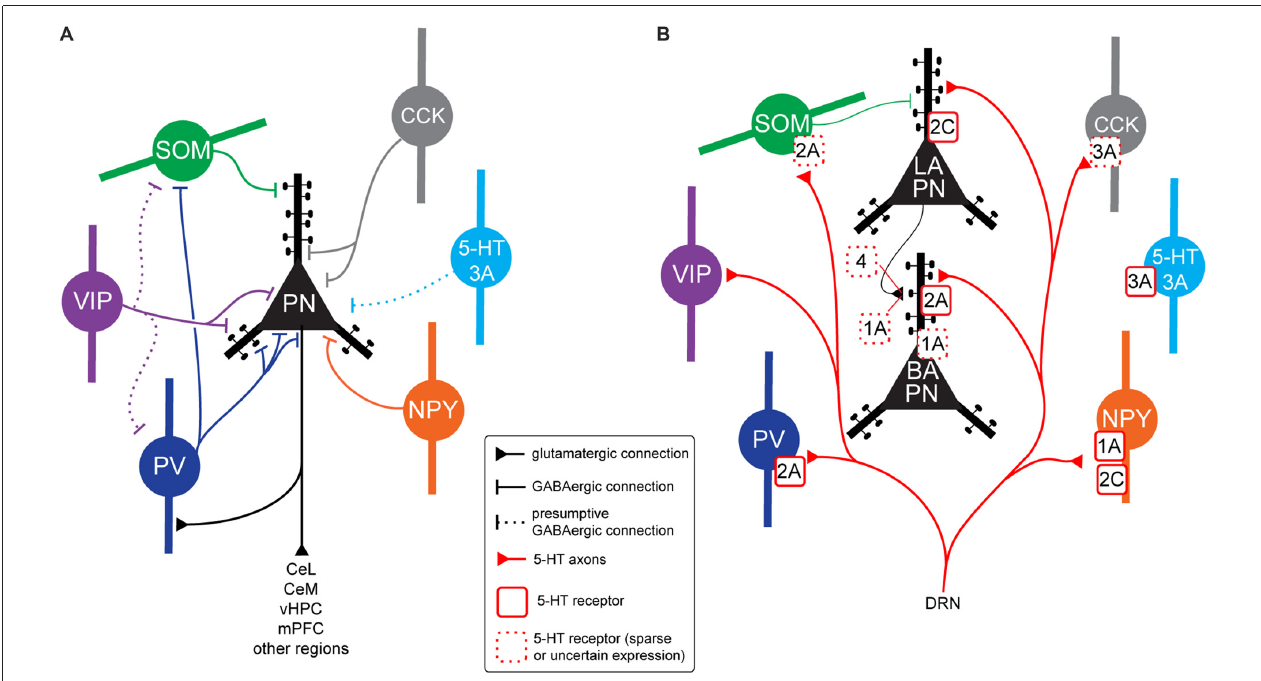
FIGURE 2 | BLA neurons connectivity, 5-HT innervation and 5-HT receptor expression. (A) Connectivity between BLA principal neurons (PNs) and interneuron (IN) populations in rodents. Parvalbumin (PV) INs target the perisomatic region of PNs (soma, proximal dendrites, axon initial segment), but also inhibit somatostatin-expressing (SOM) INs, disinhibiting PNs distal dendrites. Vasoactive intestinal peptide (VIP) INs inhibit PN soma and proximal dendrites. As they have been shown to inhibit high numbers of Calbindin (CB)-expressing (CB+) INs, and the majority of CB+ INs are either PV or SOM, VIP INs could target PV and/or SOM INs, disinhibiting specific PN subcellular compartments, but this has not been demonstrated. The VIP-negative CB1R+ population of Cholecystokinin (CCK) INs (large CCK) target PN perisomatic region. Although it is likely that CCK-negative 5-HT3A+ INs contact PNs, this has not been shown experimentally. A subset of neuropeptide Y (NPY) INs (neurogliaform cells) have been shown to inhibit PN soma and proximal dendrites. (B) Expression of 5-HT receptors in neuron types of the BLA in rodents. All the IN populations illustrated have been shown to receive somatic and/or dendritic 5-HT innervation (apart from CCK-negative 5-HT3A INs). PV INs express excitatory, metabotropic 5-HT2A receptors. Thirty percent of SOM INs also seem to express 5-HT2A. Ionotropic, excitatory 5-HT3A receptors are expressed by a small proportion of CCK INs and a population of INs not expressing any other known marker. NPY INs express either inhibitory, metabotropic 5-HT1A receptors or excitatory, metabotropic 5-HT2C receptors. In some cases, both receptors could be localized on the same neuron. It is not clear what 5-HT receptor may be expressed by VIP INs. In the whole BLA, PNs are innervated by 5-HT axons only on dendrites, often on spines. In the lateral amygdala (LA), they appear